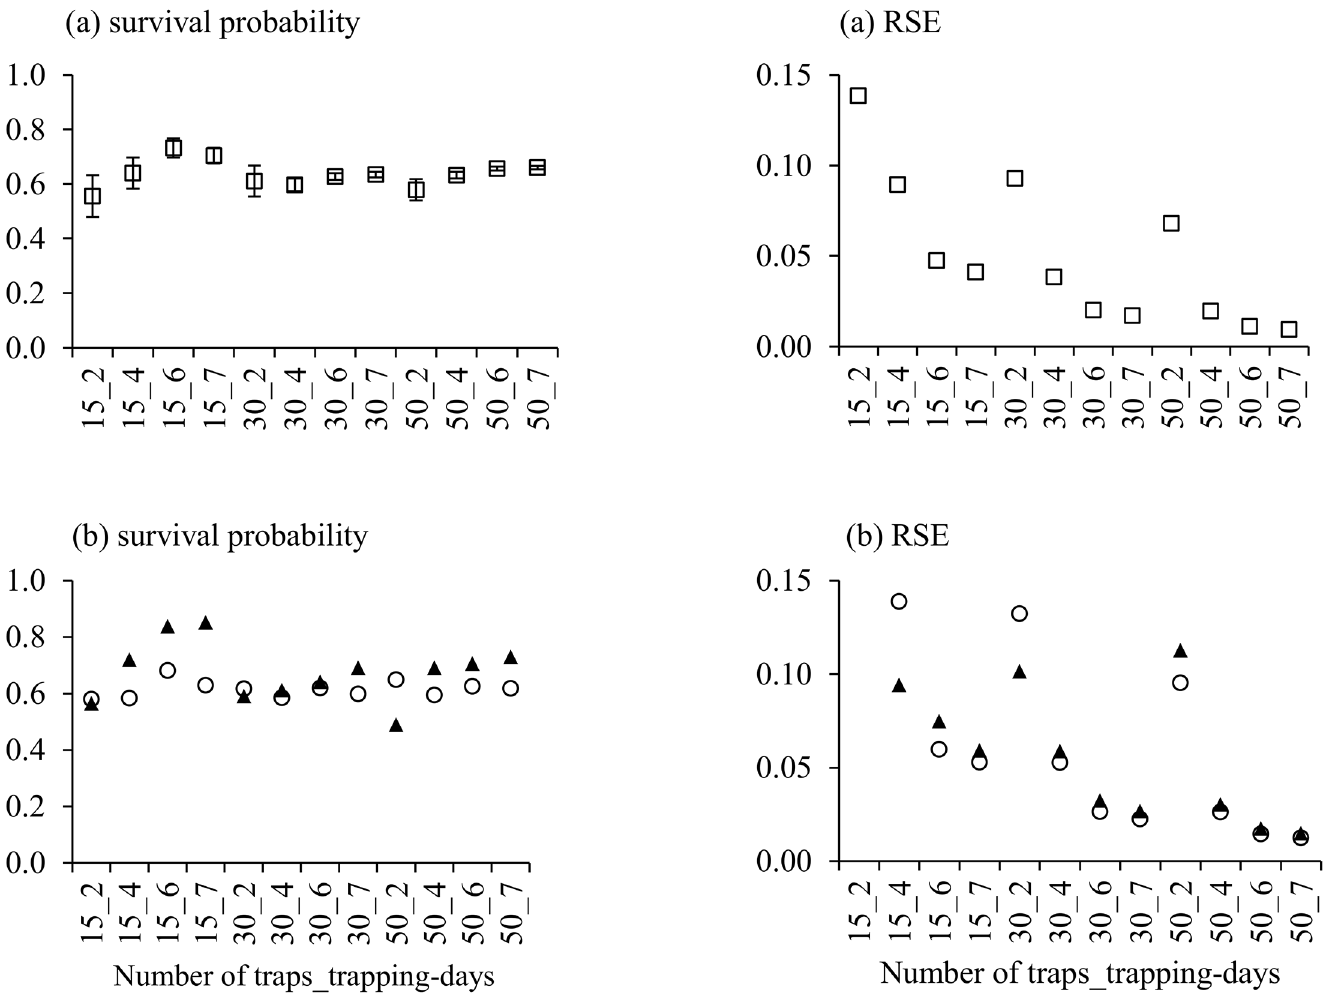
Fig 2. Survival probability (Phi ) and relative standard error (RSE) of lobsters — combined sexes (a) and different sexes (b) (males ( (cid:3) ) and females ( ▲ )), estimated by sex-time independent model (Phi( . )p(g)) and sex dependent model Phi(g)p(g) respectively, associated with each combination of fishing